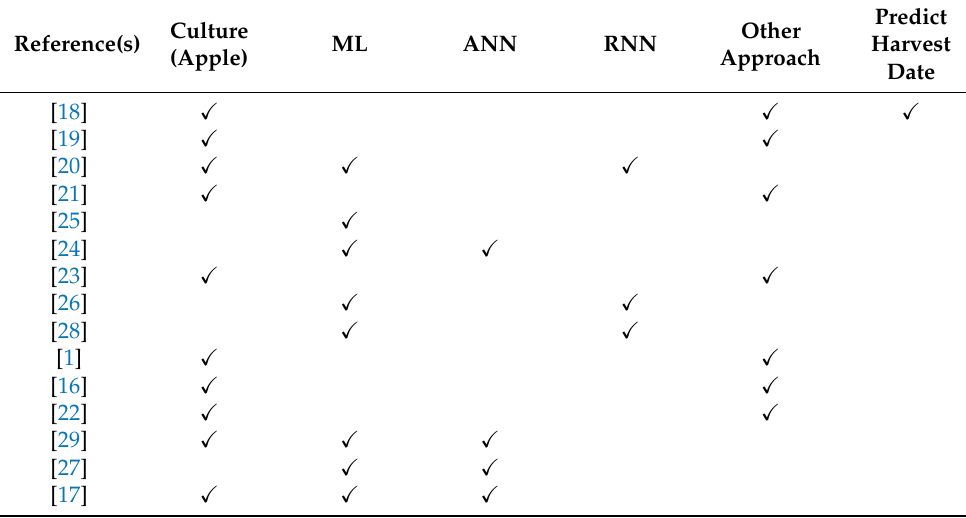
Table 1. Comparative table of approaches in the related